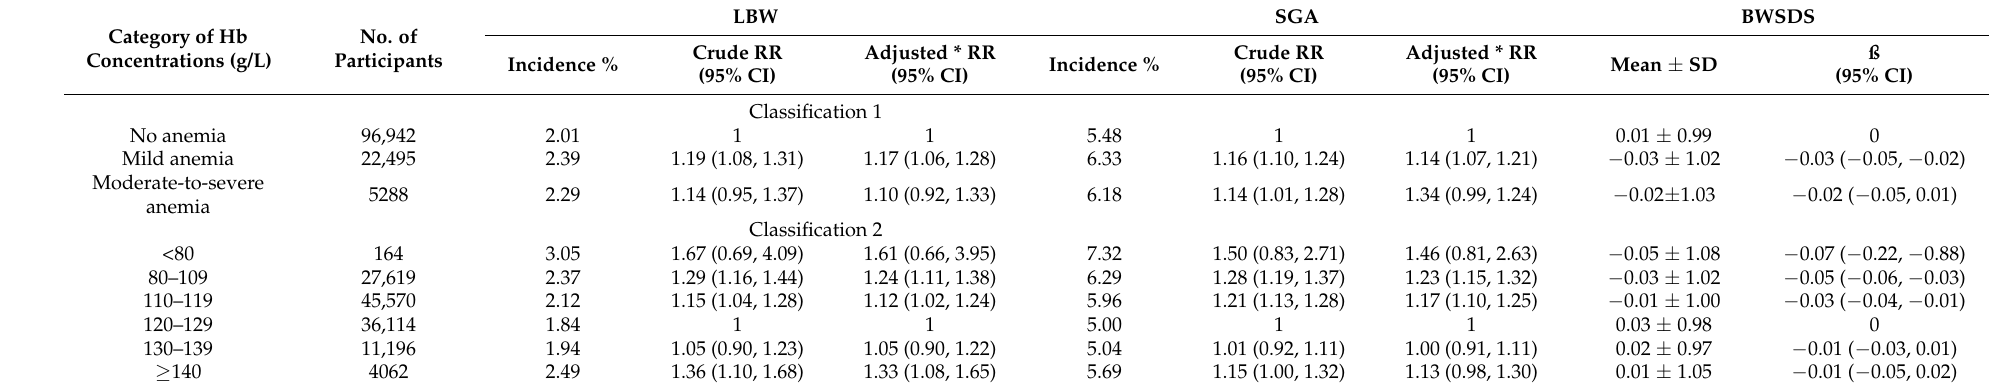
Table 4. The associations between LBW, SGA, and BWSDS with preconception hemoglobin (Hb) concentrations of women in China,